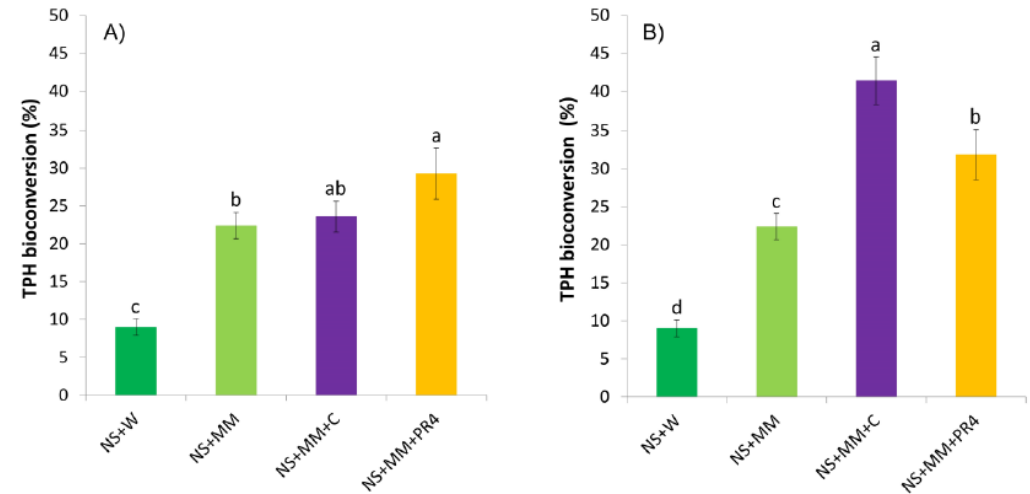
Figure 6. Bioconversion of total petrol hydrocarbons (TPH) in soil microcosms after 40 days, when applying a ( A ) smaller and a ( B ) larger size of inoculum for bioaugmentation. Different letters indicate statistical differences among treatments ( n = 15, p ≤ 0.05).